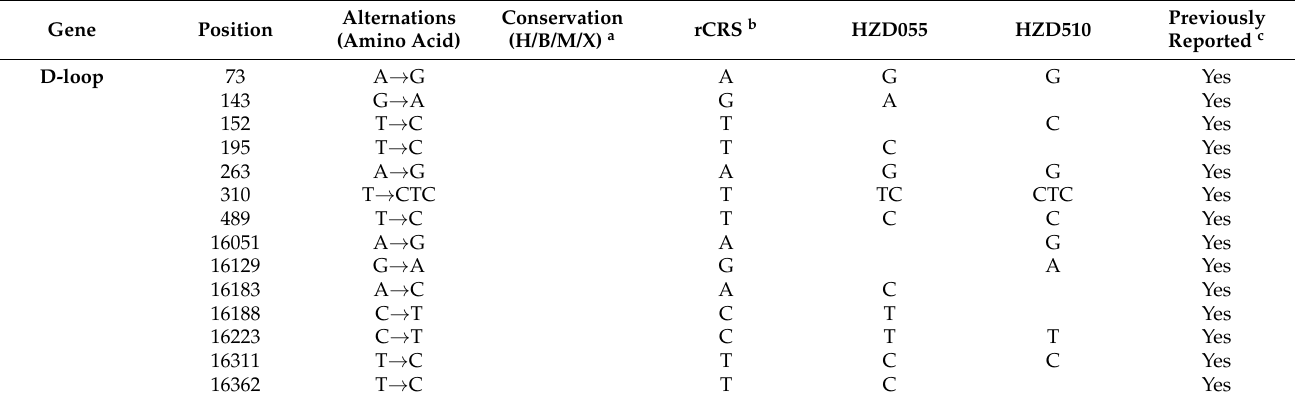
Table 3. mtDNA sequence variants in two pedigrees with hearing